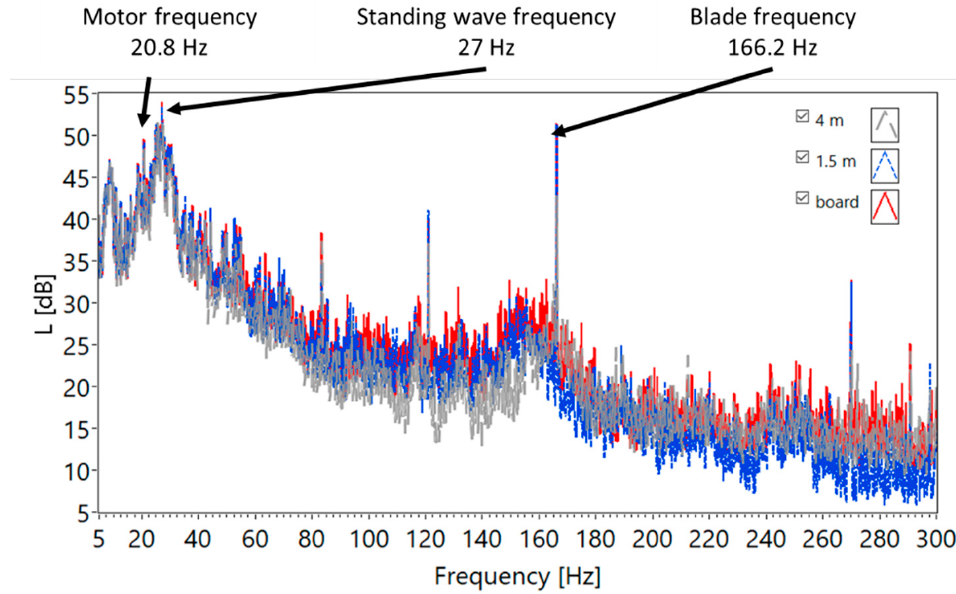
Figure 5. Ventilation shaft noise. Amplitude-frequency spectrum—wind speed 0 m/s.